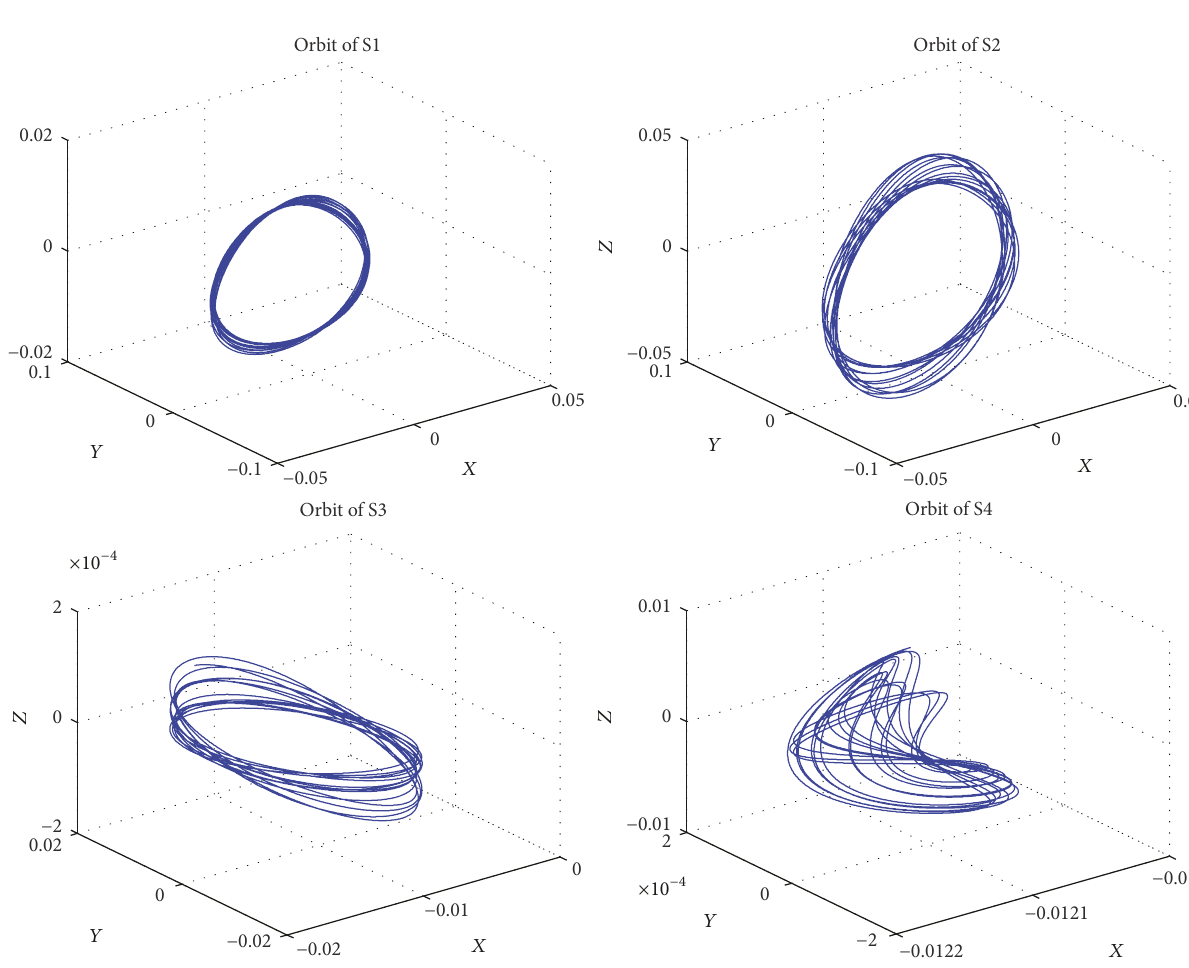
Figure 3: The quasiperiodic orbits around the L1